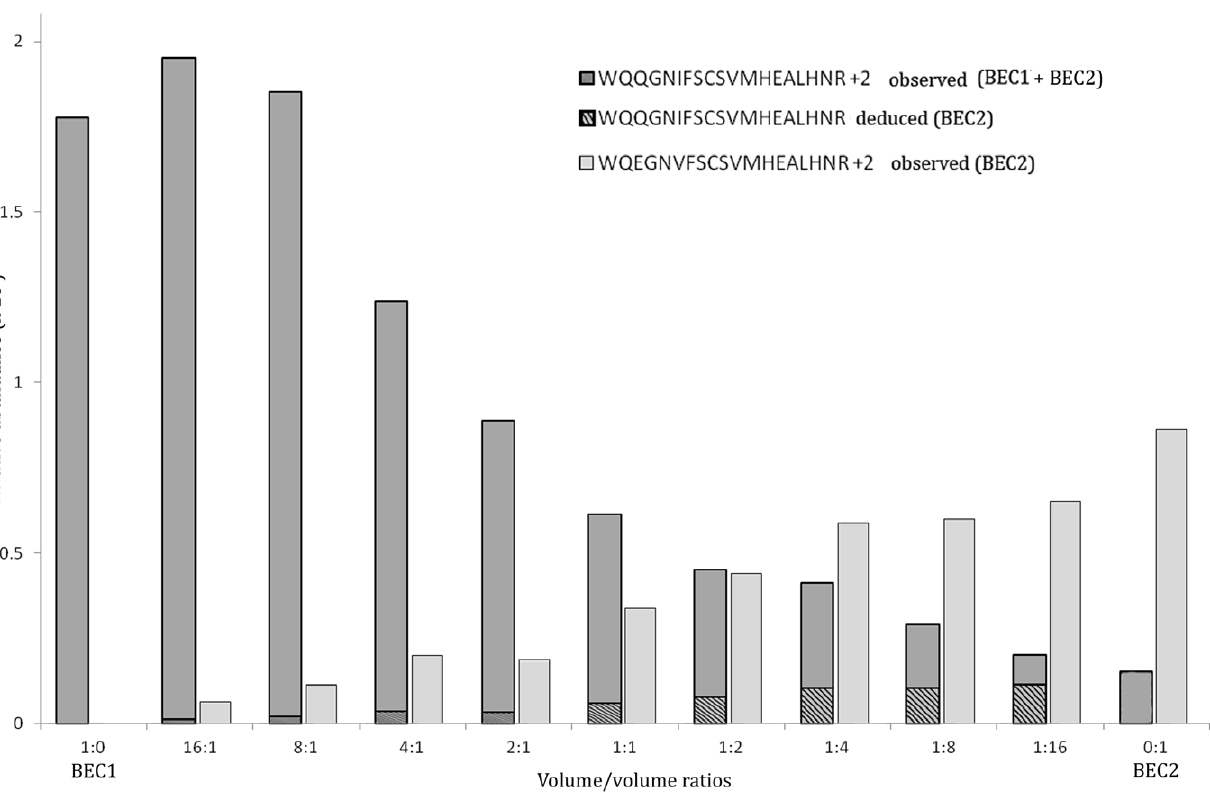
Figure 2. ESI MS/MS fragmentation profiles from three main proteotypic allelic peptides. Y axis represents the logarithm of the relative abundance + 1, x axis represents the mass to charge ratio (m/z). A. Spectra from the sample (BEC1), fragmentation of peptide ( # 24, G3m5*) (IGHG3*01,*04 to*07, *09 to*12, CH3 95–116). The database search identifies the sequence 332–350 for IMGT reference AJ390260|IGHG3*15. This sequence is found in 9 IGHG3 alleles of G3m5* and is identical to peptide ( # 25, G3m21*) found in 3 IGHG3 alleles (of which IGHG3*15) of G3m21* (as detailed in Table 2 and discussed in 2.1). In BEC1, the parallel identification of the ( # 19, G3m5) peptide confirmed that indeed the fragmented peptide is ( # 24, G3m5*) (1 + ) y fragment ion series for m/z 1129.02 with 2 charges and free cysteine; accepted nomenclature for fragment ions as proposed by Roepstorff and Fohlman [25]. B. Spectra from the sample (BEC2), fragmentation of peptide ( # 26, G3m24*) (IGHG3*03, CH3 95–116), sequence 347–365 for IMGT reference X16110|IGHG3*03. In this case, the peptide ( # 26, G3m24*) is highly discriminatory as it corresponds not only to a single allotype (G3m24*) but also to a single IGHG3 allele (IGHG3*03), (1 + ) y fragment ion series for m/z 1122.50 with 2 charges and free cysteine. C. Spectra from the sample (BEM3), fragmentation of peptide ( # 27, G3m26*) (IGHG3*13, CH3 95–116), sequence 347–365 for IMGT reference AJ390244|IGHG3*13. As in (B), the peptide ( # 27, G3m26*) is highly discriminatory as it corresponds to a single allotype (G3m6*) and to a single IGHG3 allele (IGHG3*13), (1 or 2 + ) y or (1 + ) b fragment ion series for m/z 753.02 with 3 charges and free